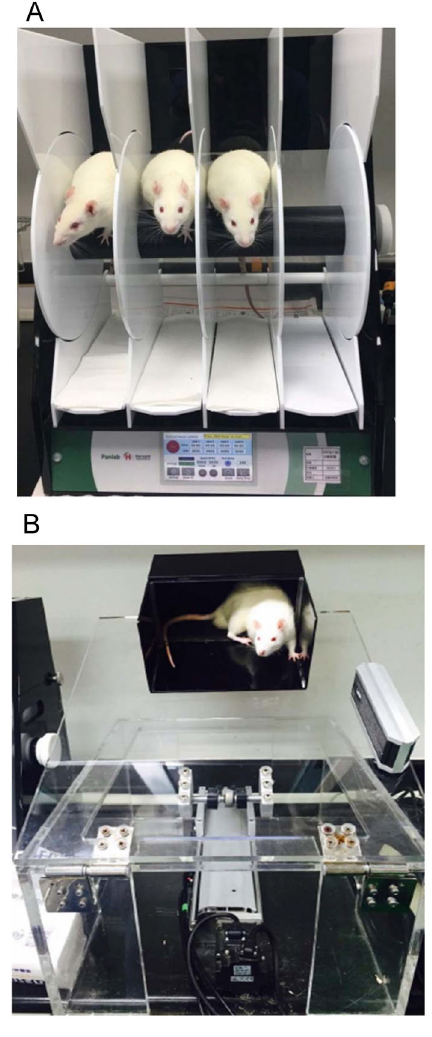
Figure 7. Behavior assessment tools for animal nerve damage. A , Rota-rod test (balance bar roller). B , Inclined plate test.